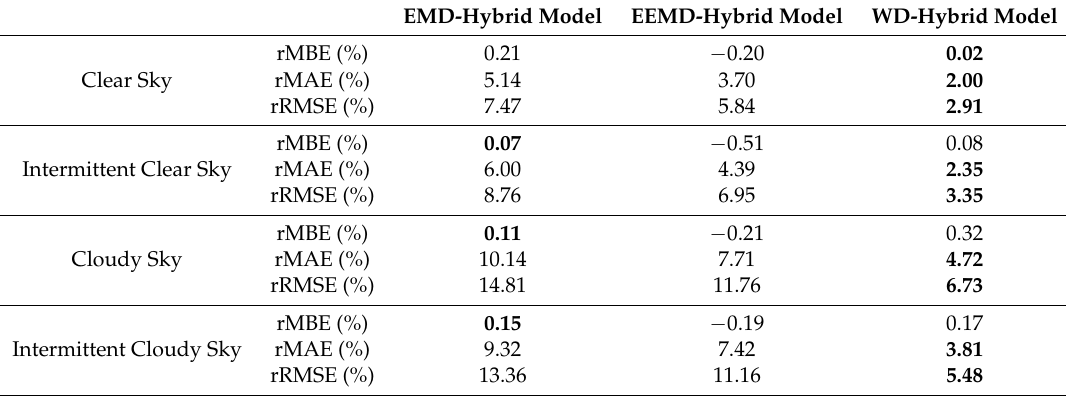
Table 5. Forecasting performances of MHFM for the four specific class of